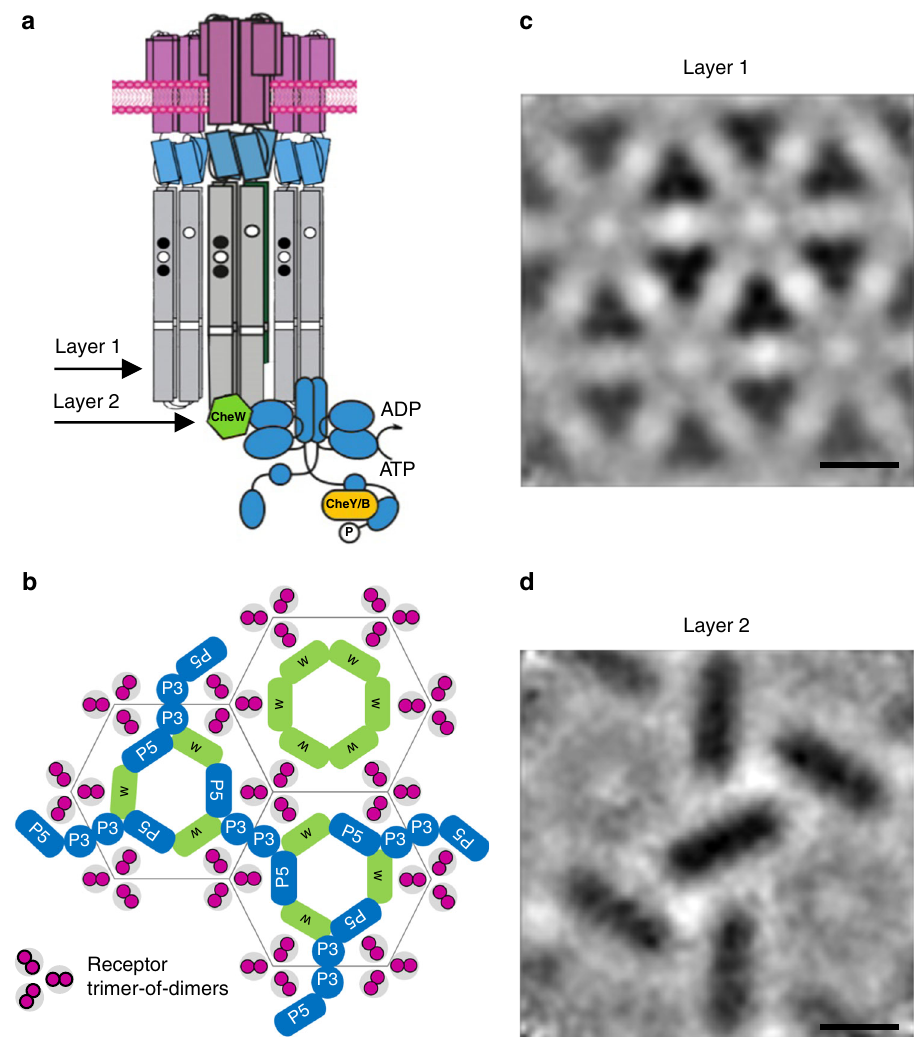
Fig. 1 The arrangement of the canonical chemoreceptor array, exempli fi ed in Escherichia coli ( Ec ). a Transmembrane chemoreceptors function as a trimer-of-dimers module to modulate the activity of the histidine kinase CheA (blue) via a coupling protein CheW (green). In cryo-ET experiments, cross- sections at Layer 1 reveal the arrangement of chemoreceptors and Layer 2 reveals the position of the kinase. b In all organisms investigated previously, CheA is integrated into the array with hexagonal (pseudo-P6) symmetry. c Previous cryo-ET experiments in E. coli reveal the hexagonal receptor arrangement at Layer 1 and d the pseudo-P6 CheA arrangement at Layer 2 (EMDB-4991) 25 . Scale bars are 6